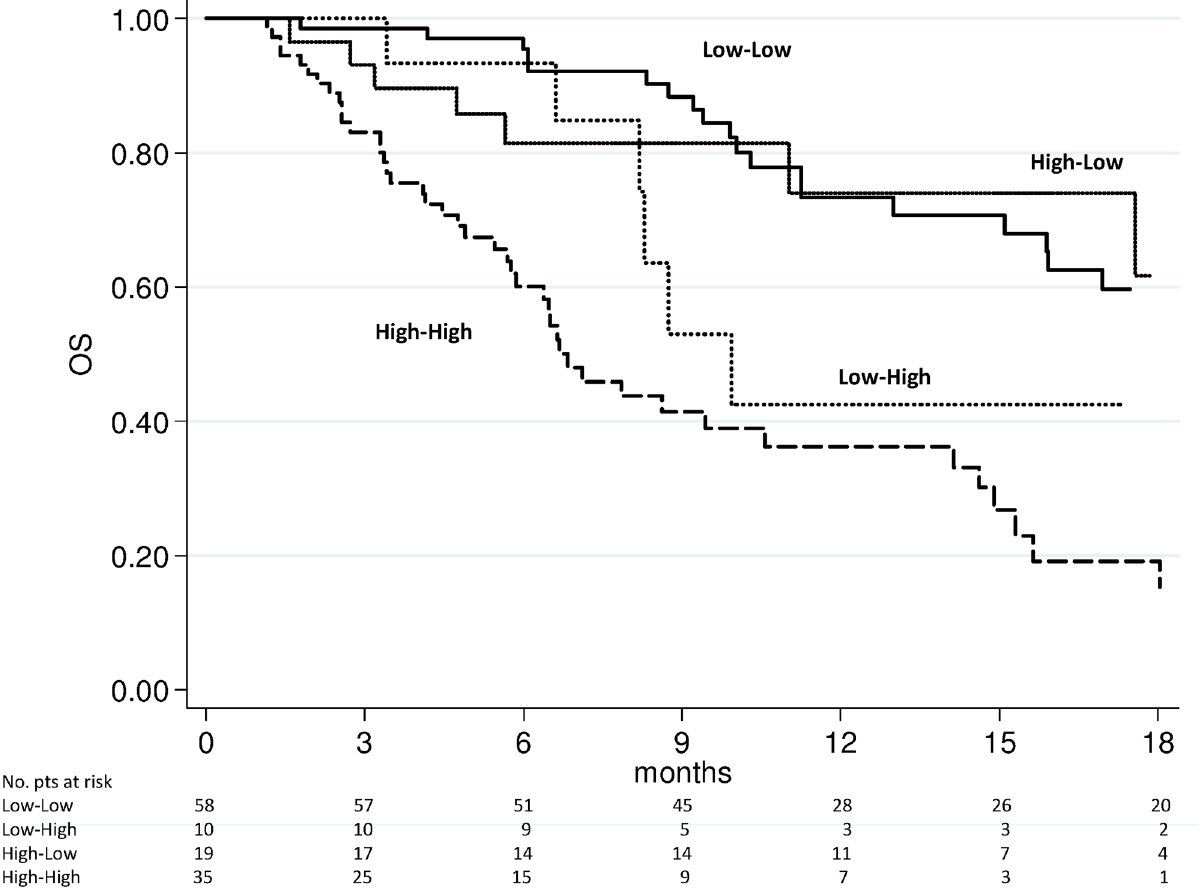
Fig 6. Overall survival according to pre-therapy and follow-up NLR at 12 weeks of enzalutamide treatment.